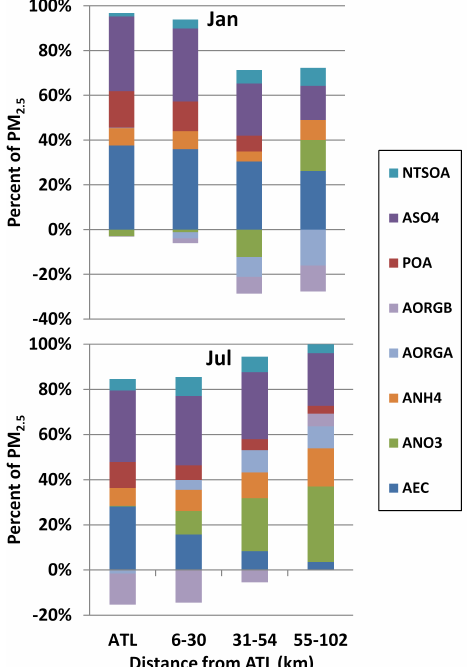
Figure 5. Monthly average composition of aircraft-attributable PM 2 . 5 at the grid cell containing ATL and at various distances away from ATL. Note that absolute aircraft-attributable PM 2 . 5 concentra- tions are approximately 15 (6–30km), 94 (31–54km), and 196 (55– 102km) times lower moving away from ATL in January and 8, 13, and 16 times lower in